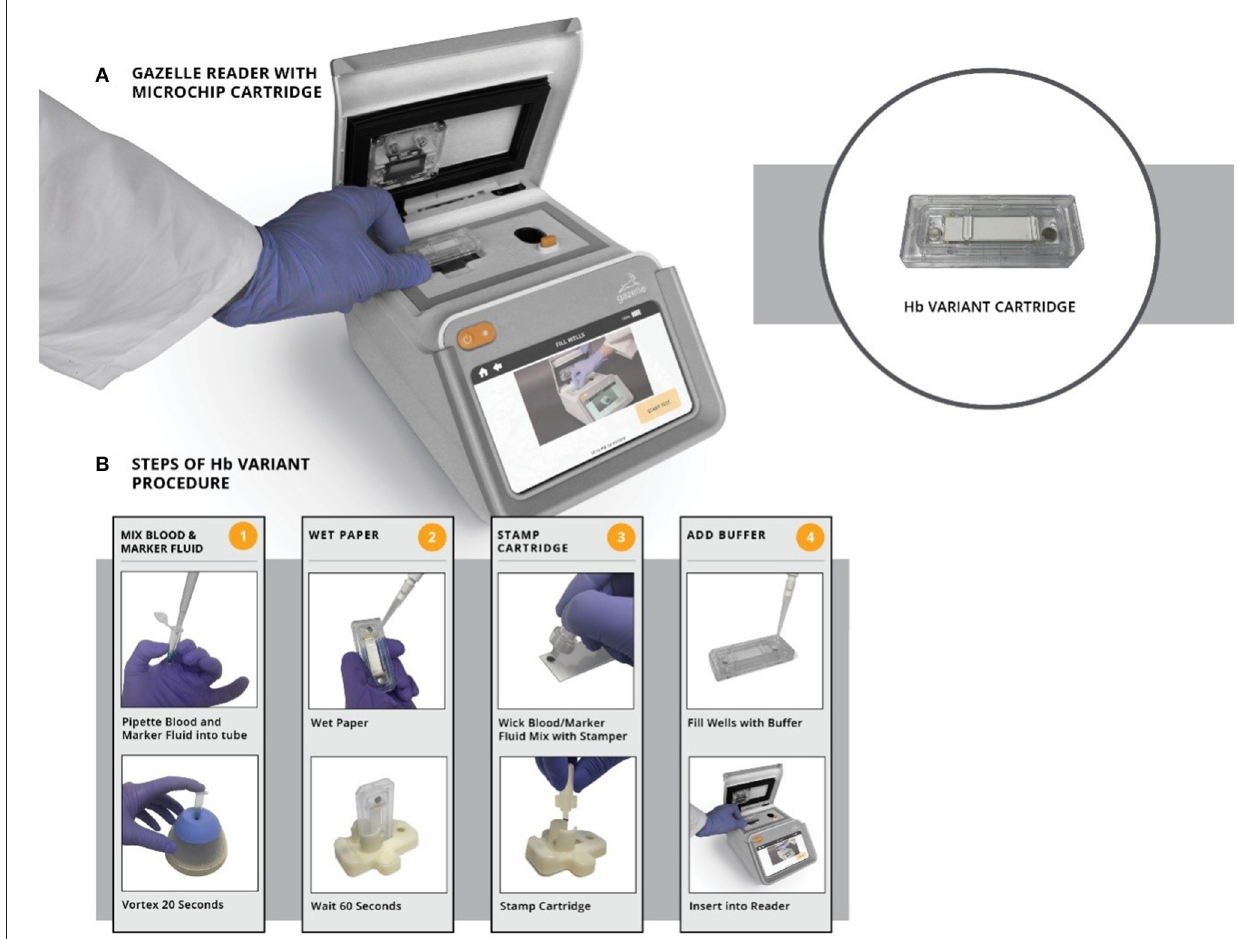
FIGURE 1 | Gazelle-microchip electrophoresis: (A) Gazelle Reader with Cartridge. (B) Steps of Gazelle Hb Variant